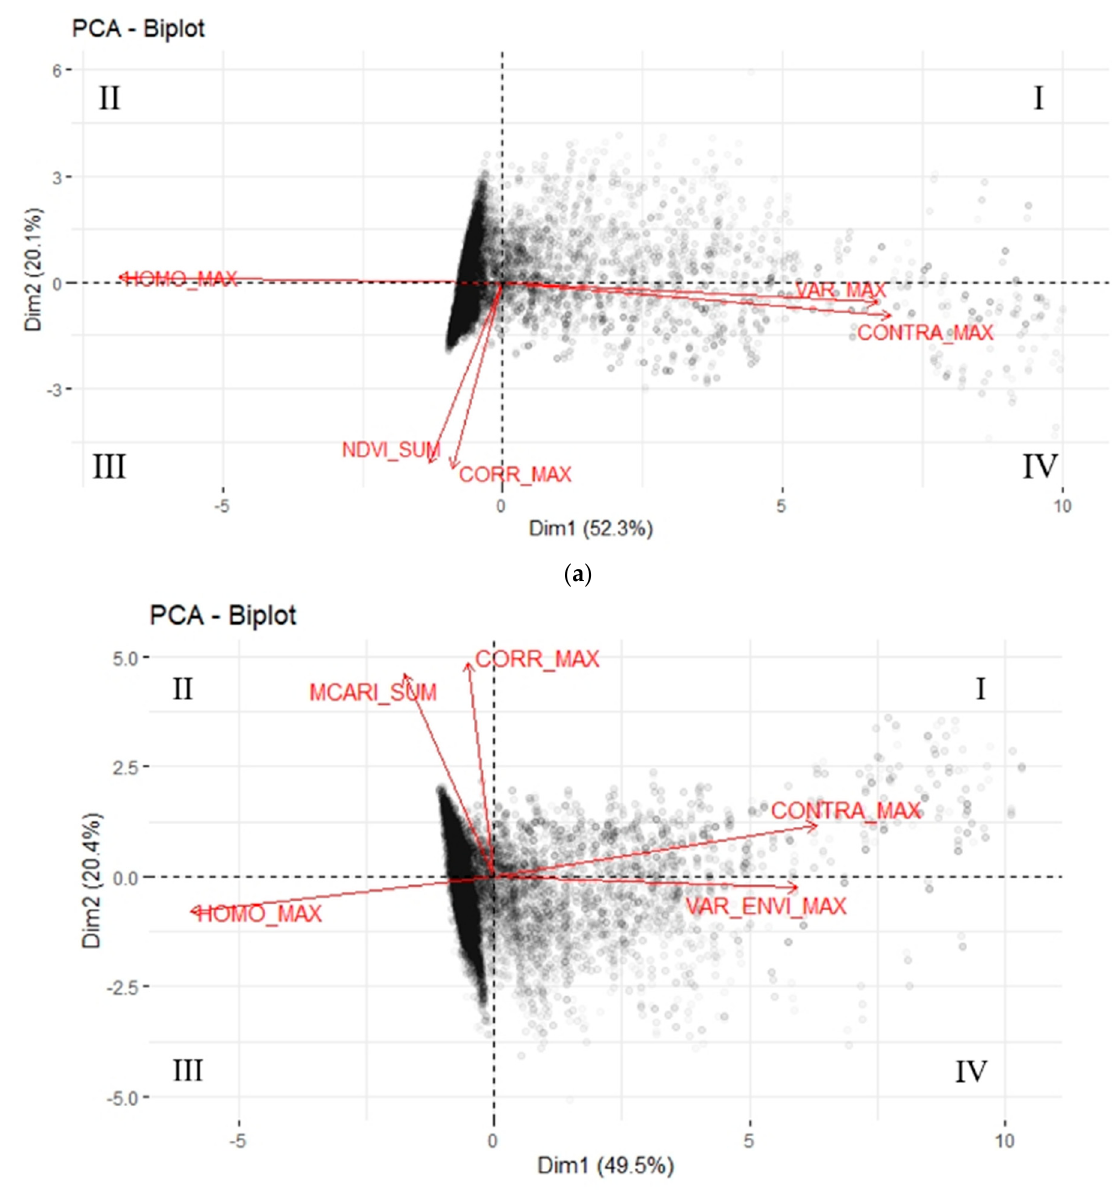
Figure 6. Multivariate analysis of the NDVI ( a ) and MCARI2 ( b ) indexes and GLCM characteristics. Regarding the NDVI, homogeneity ( − 0.57) and contrast (0.57) showed greater influence on the first component (Table 6), while correlation (0.66) and NDVI_sum (0.64) showed the greatest influence on the second component. In the case of MCARI2, variance (0.55), homogeneity ( − 0.55), and contrast (0.59) showed the greatest influence on the first component (Table 6), while the correlation (0.71) and the MCARI2_sum ( − 0.67) showed the greatest influence on the second